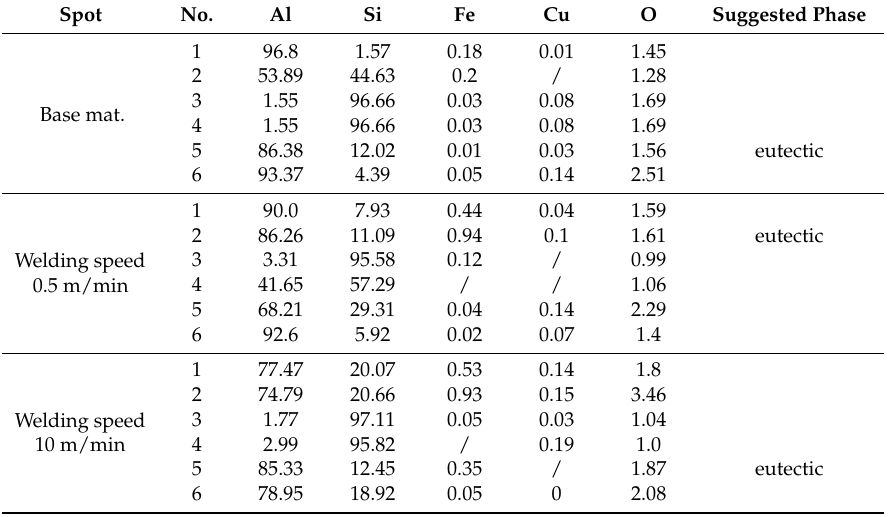
Table 3. Composition of S220 measured by WDX for a welding speed of 0.5 m/min (at. %). Spot/Phases No. Al Si Fe Cu O 1 “bright” phase Base mat. 1 “dark” phase